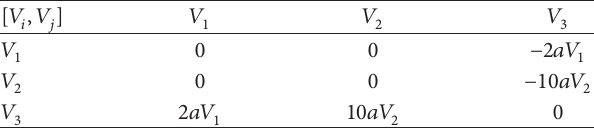
Table 3: Commutator table of the Lie algebra of